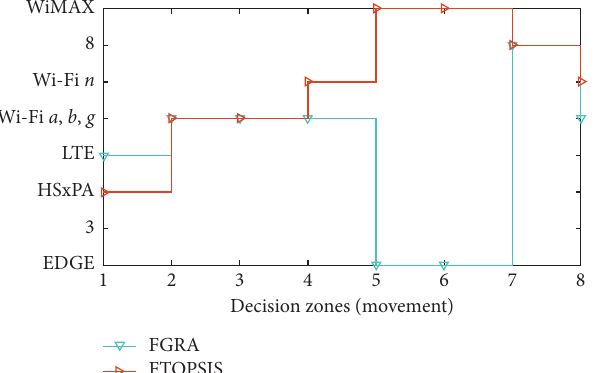
Figure 5: Decisions made during the movement scenario by using FTOPSIS and FGRA with FANP.